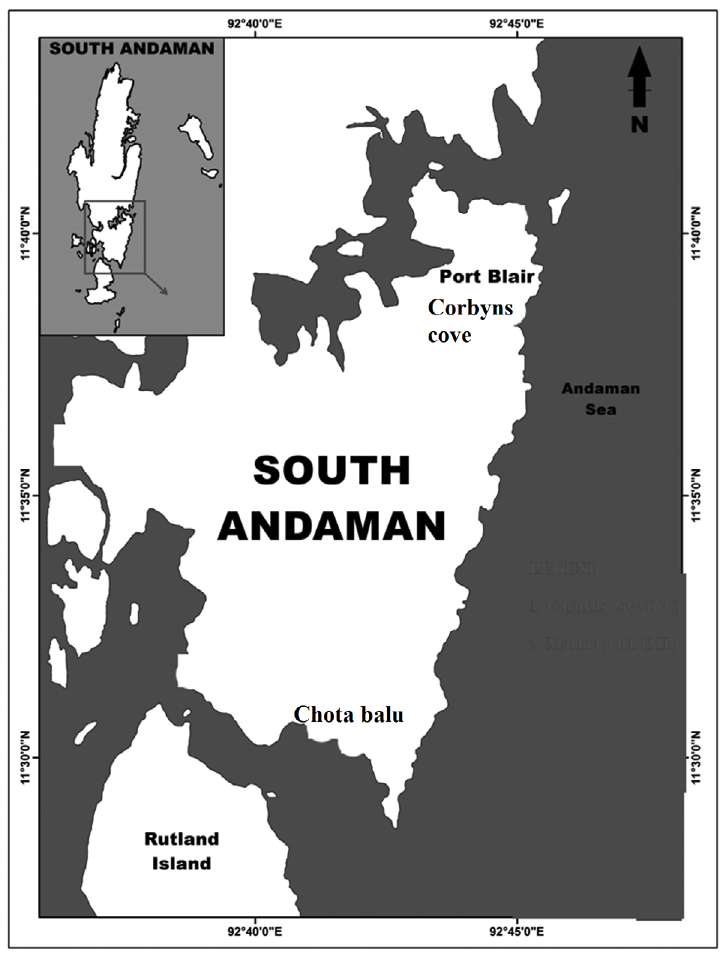
Figure 1. Map showing the study